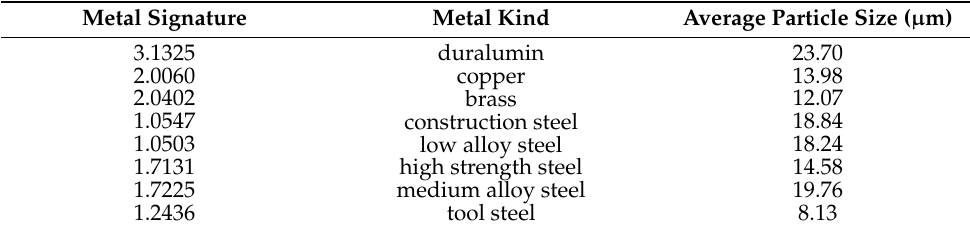
Table 7. The average abrasive particle sizes detected on the cutting walls of particular metals measured on the microscope images using CorelDRAW ® Home & Student 2018 software (Corel Corporation, Ottawa, ON,